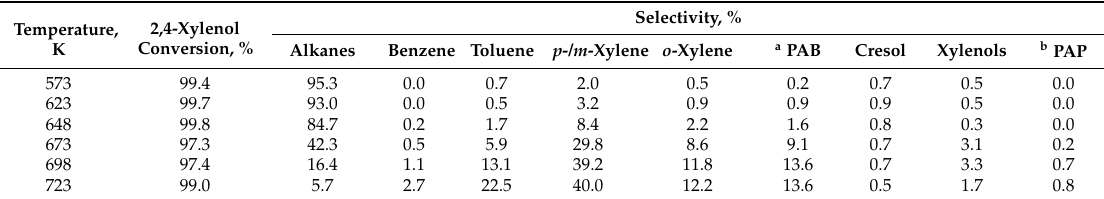
Table 2. Product selectivity and conversion for 2,4-xylenol hydrodeoxygenation. Temperature, K